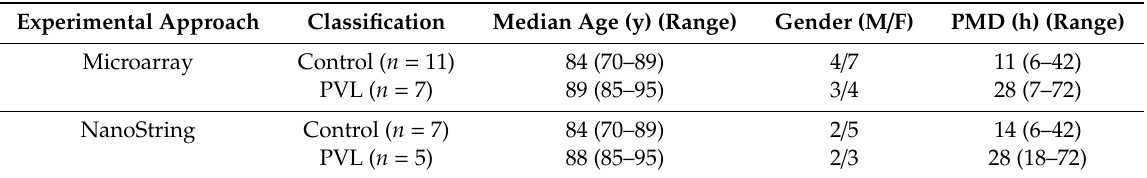
Table 8. Cohort demographics.